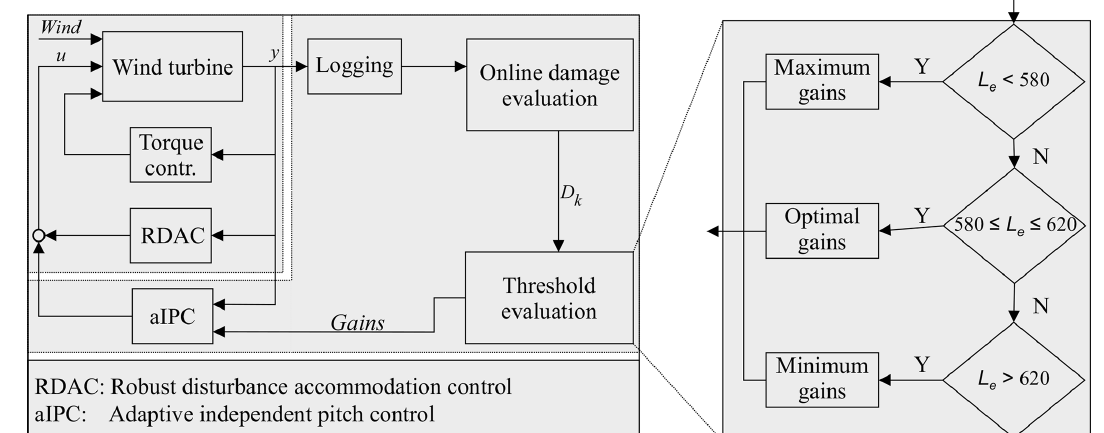
Figure 4. Prognostics-based adaptive lifetime control.